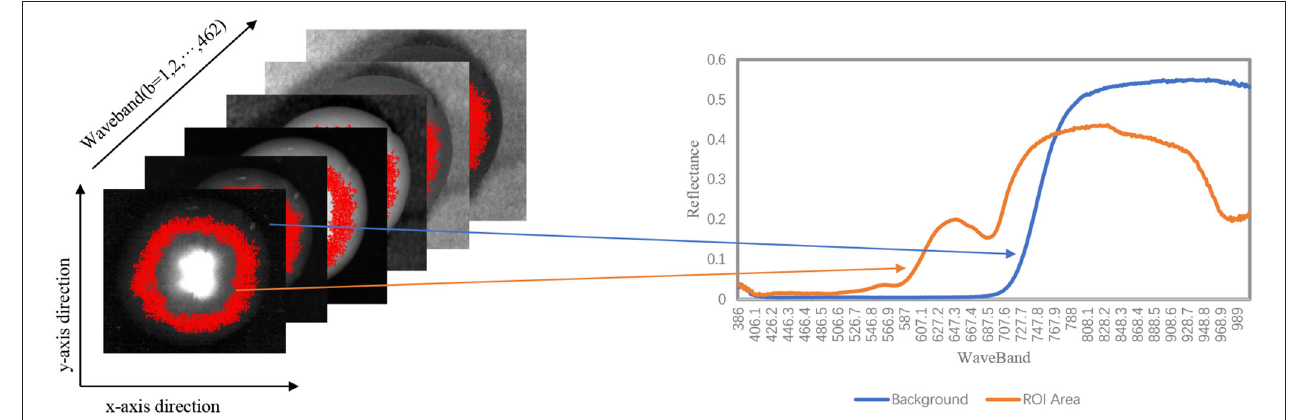
FIGURE 3 | Schematic diagram of the structure and data of the corrected hyperspectral image: spatial axis x, y, and